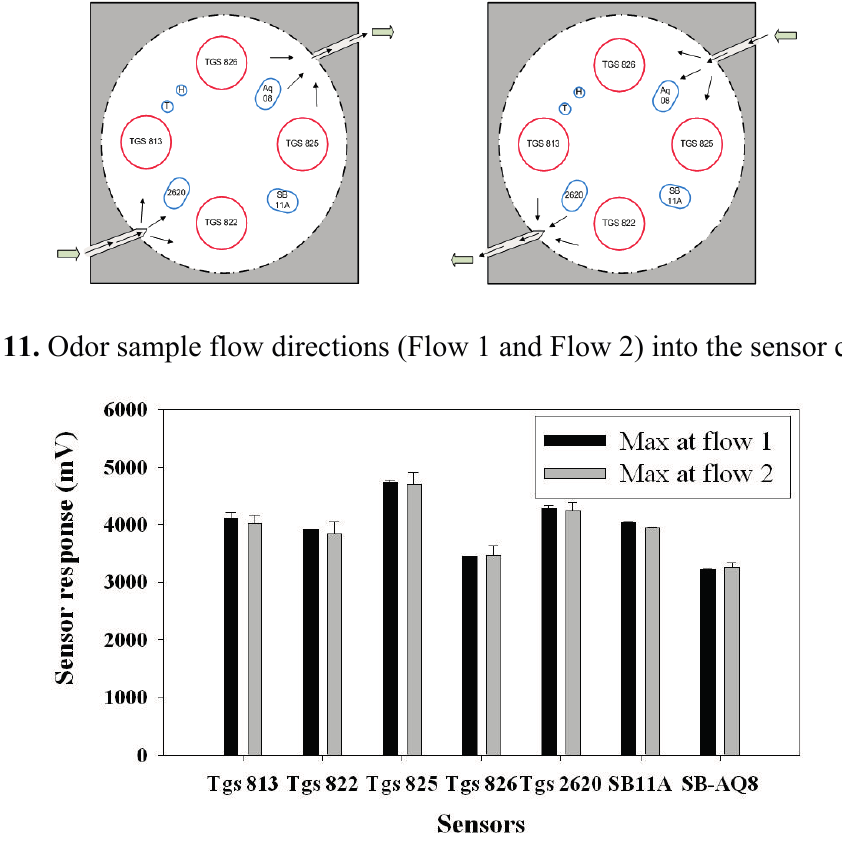
Figure 12. Maximum response (mean ± SD) for 100% ethanolreached by the MOS sensors when tested for two different flow